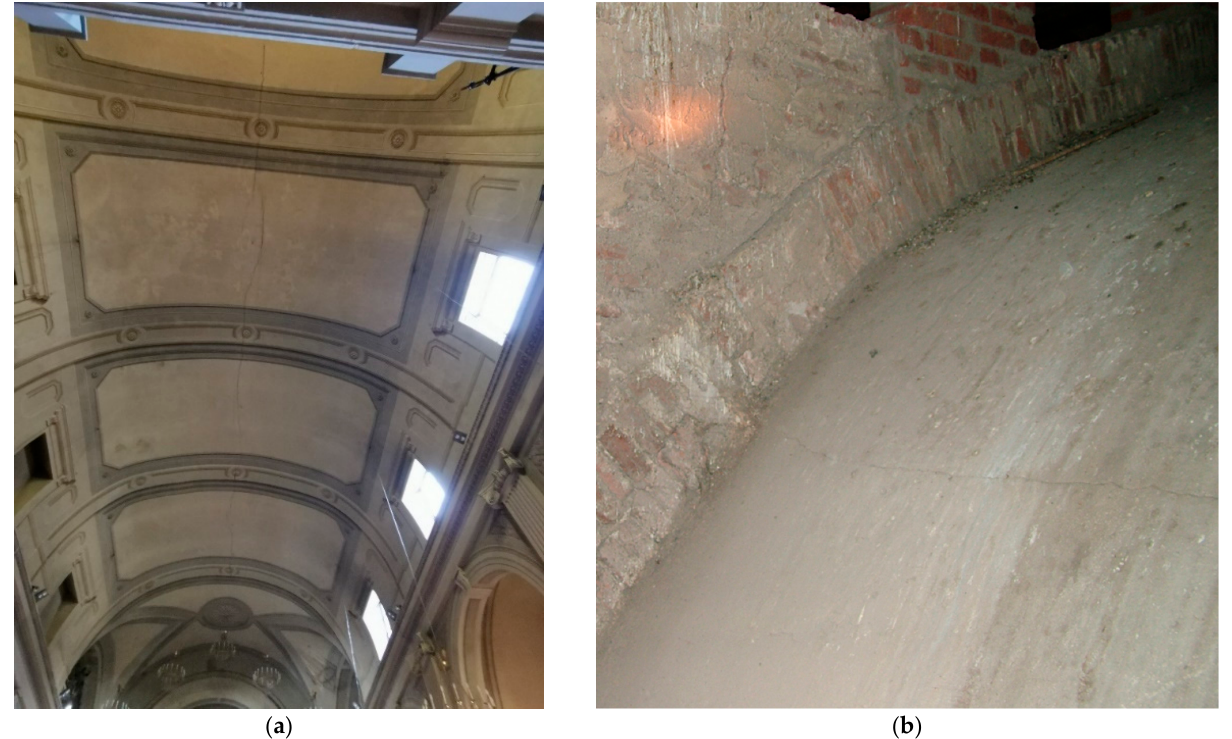
Figure 15. Longitudinal hinged cracks of the barrel vault of the nave: ( a ) longitudinal crack at the intrados; ( b ) longitudinal crack at the extrados of the barrel vault haunches.